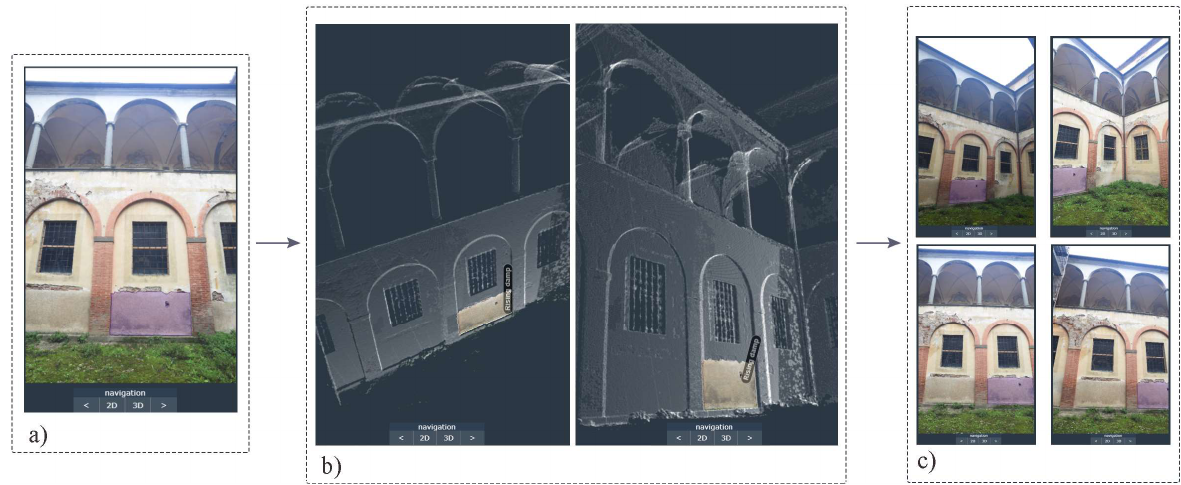
Figure 4. Processing steps via Aïoli: (a) selection of the annotation on the first image, (b) detection of 3D points corresponding to the selection and (c) propagation of the annotation on the other images of the set